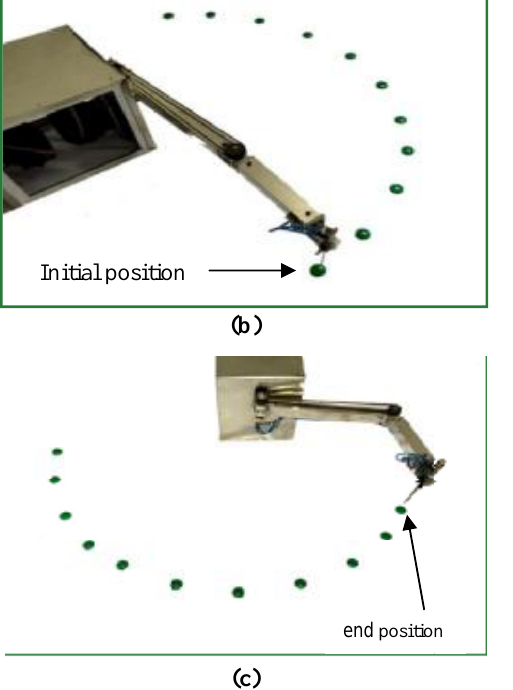
Fig. 17. ( a) The Path for The Third Motion in Matlab (b&c) The Third Practical